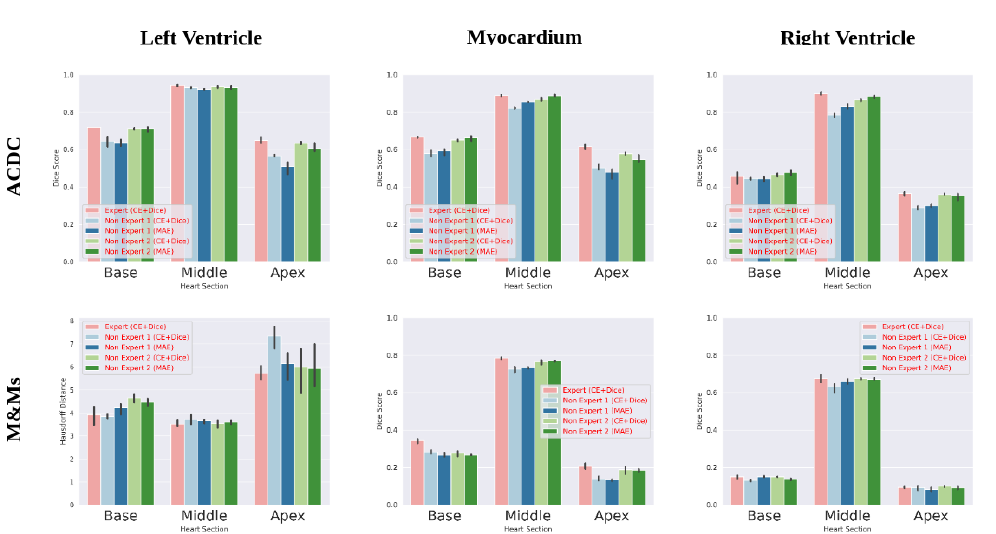
Figure 3. Dice score on ACDC and M&Ms data set per anatomical structure and per slice